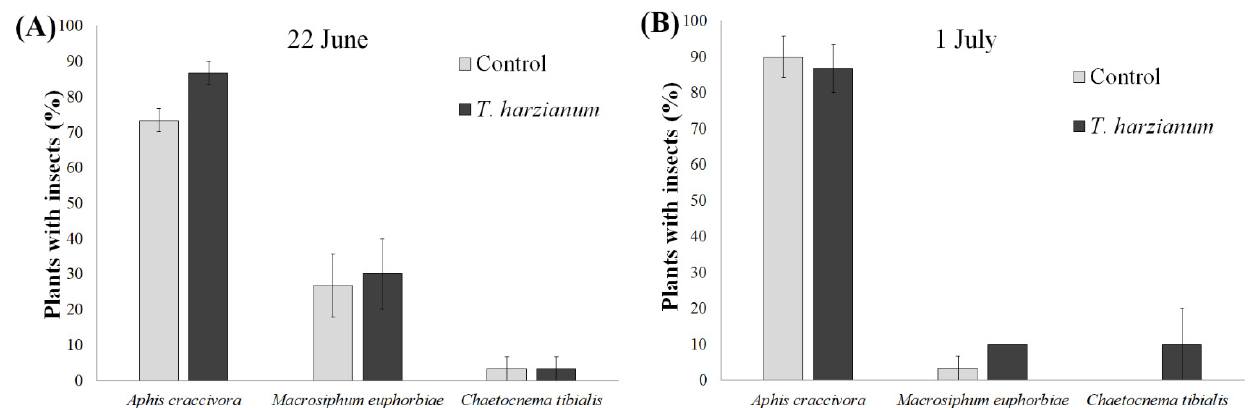
Figure 2. Presence of phytophages on tomato seedlings. Mean values (± standard errors) of the percentage of tomato seedlings showing the presence of phytophagous insects, as recorded on 22 June ( A ) and on 1 July ( B ).